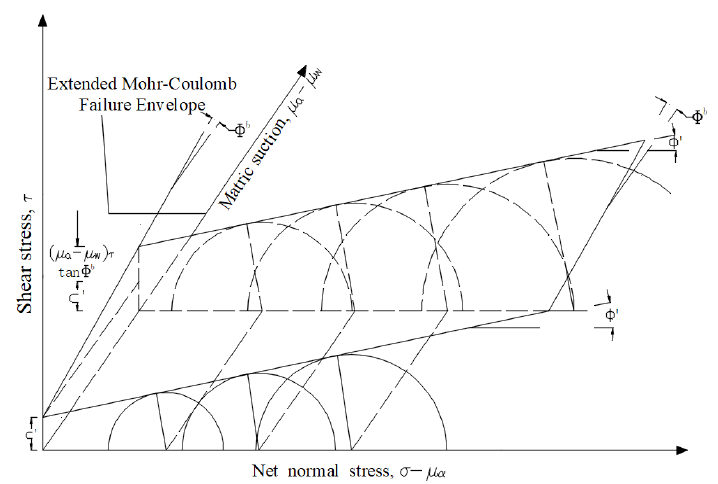
Figure 1. Extended failure linear envelope in the Mohr–Coulomb diagram.